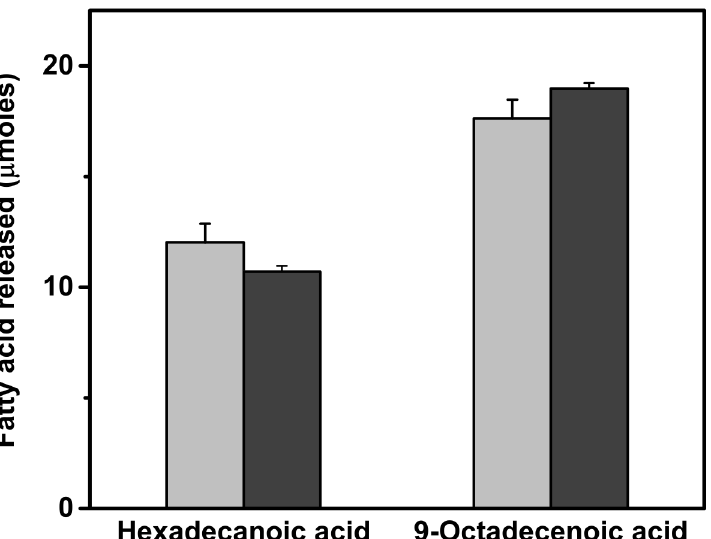
Fig 7. Lipase hydrolysis of structured triglyceride: 1,3-dioeoyl-2-myristic triglyceride was subjected to hydrolysis by PLA1 (Light) and BSL (Dark) and the released fatty acids were quantified by GC